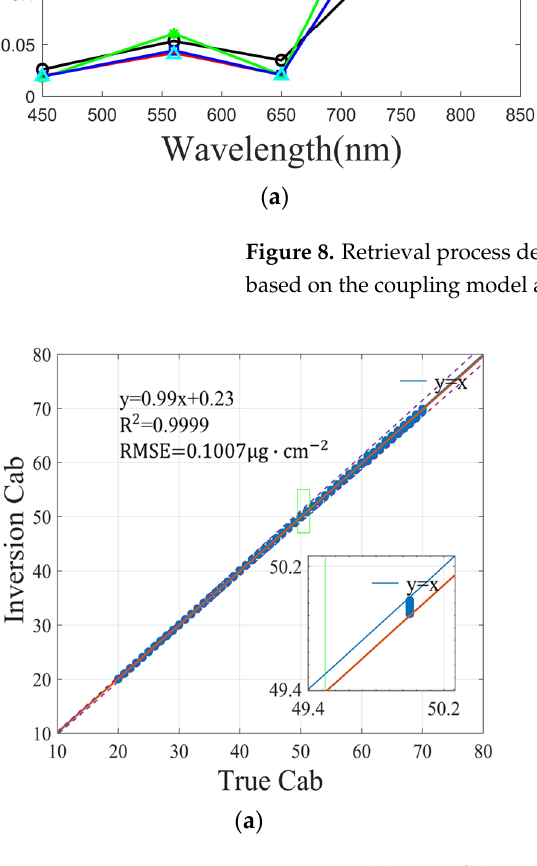
Figure 8. Retrieval process demonstration: ( a ) the illustration of the iterative process for reflectance based on the coupling model and ( b ) the description of the convergence process for the cost function.